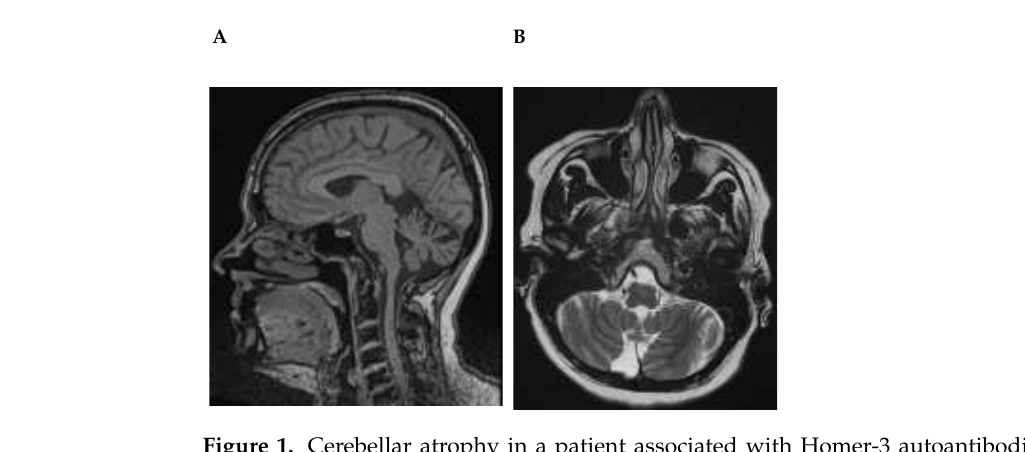
Figure 1. Cerebellar atrophy in a patient associated with Homer-3 autoantibodies. ( A ) Sagittal T1-weighted magnetic resonance imaging (MRI) and ( B ) transversal T2-weighted MRI showing cerebellar atrophy. Table 3. Criteria for the autoimmune genesis of the